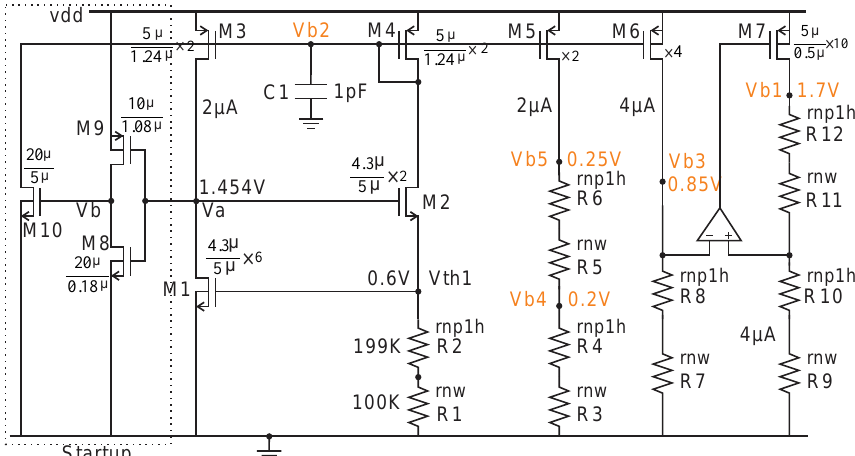
Figure 15. BGR for providing bias voltages Vb1–Vb5.